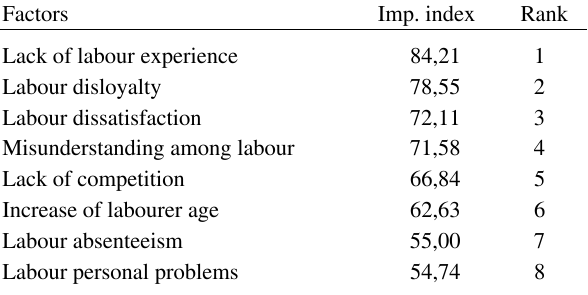
Table 1. Ranking factors under manpower group Factors Imp.